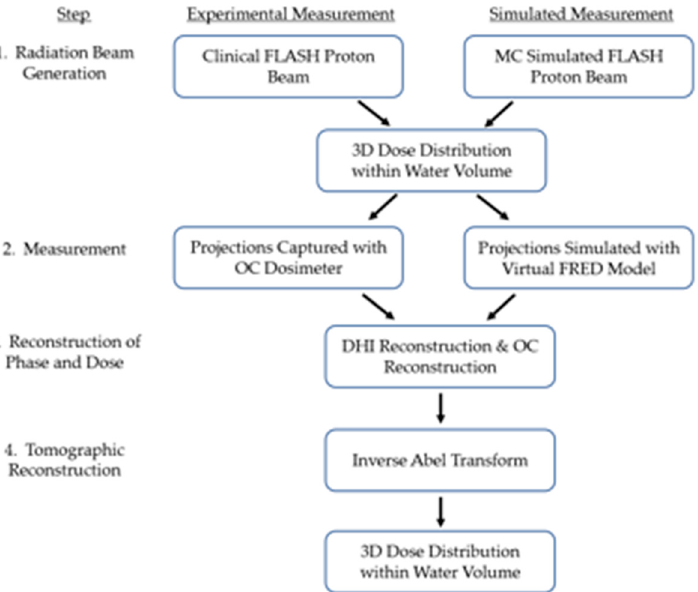
Figure 1. Flow diagram indicating the workflow to obtain a dose. The steps on the left refer to the processes that are involved when taking an experimental measurement with the DHI-based OC dosimeter, while the right-hand side steps indicate the models used to simulate the experimental measurements used in this work.